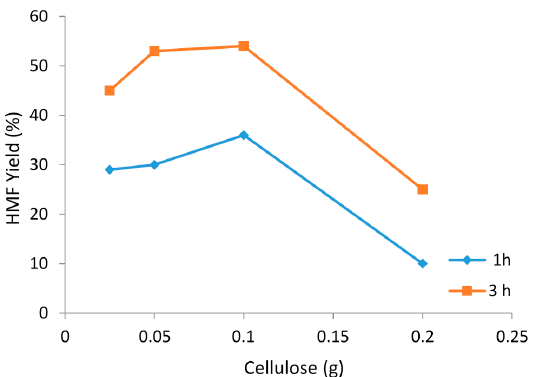
Figure 6. HMF yield from cellulose at 120 °C in [C 4 C 1 im]Cl; 0.7 g ionic liquid; 7 mol % CrCl 3 ·6H 2 O catalyst. HMF yields shown were determined in the IL by 1 H NMR spectroscopy.